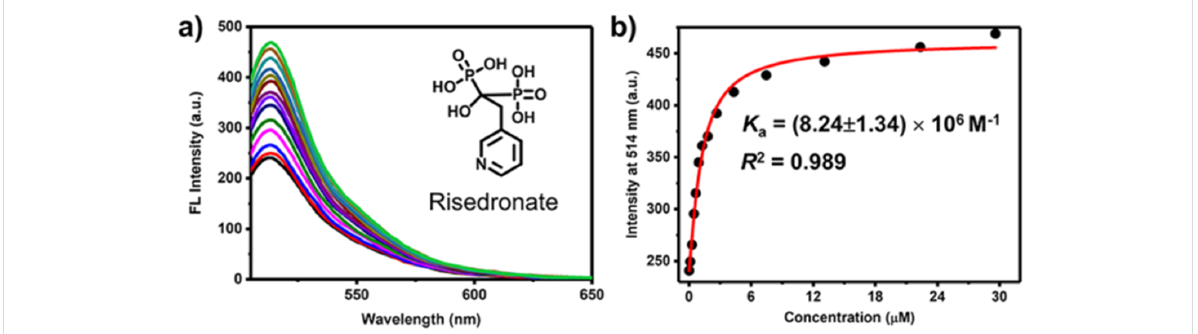
Figure 1: (a) Fluorescence competitive titration of GC5A·Fl (0.9/1.0 μ M) with risedronate (up to 29.6 μ M) in HEPES buffer (10 mM, pH 7.4) at 25 °C, λ ex = 500 nm. (b) The competitive titration curve, λ em = 514 nm, and fitting data according to a 1:1 competitive binding model.